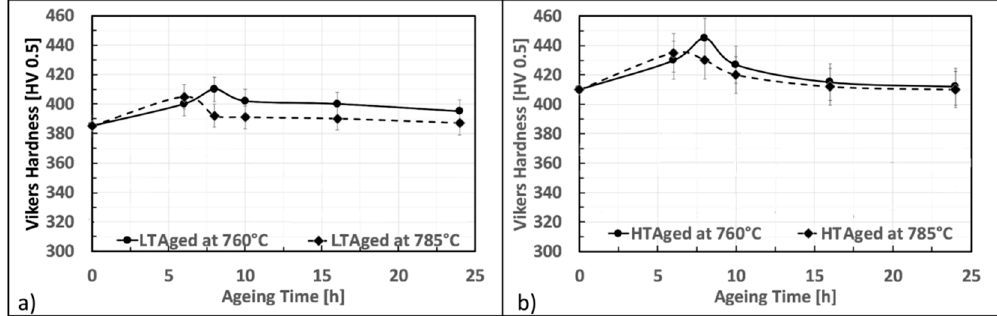
Figure 4. First aging curves for low-temperature (LT) samples ( a ) and high-temperature (HT) samples ( b ).